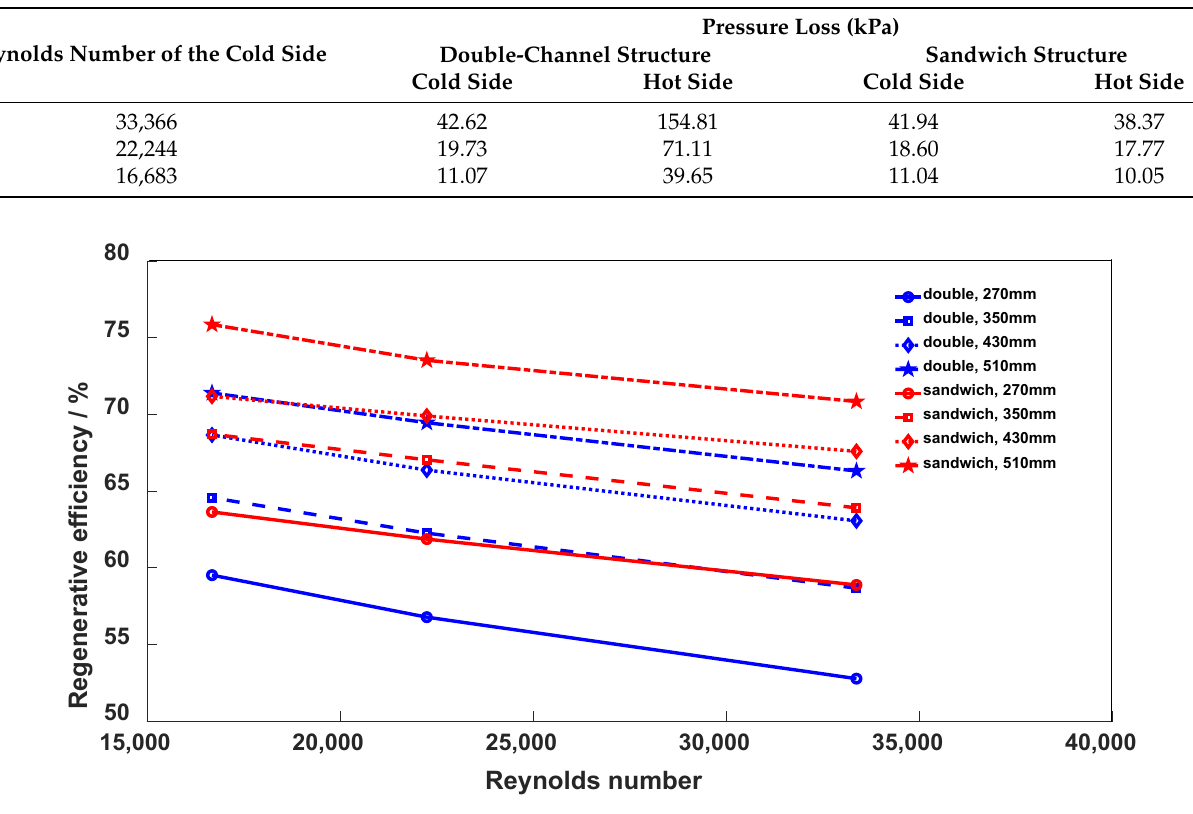
Figure 8. Efficiency comparisons at different Reynolds numbers and flow lengths.